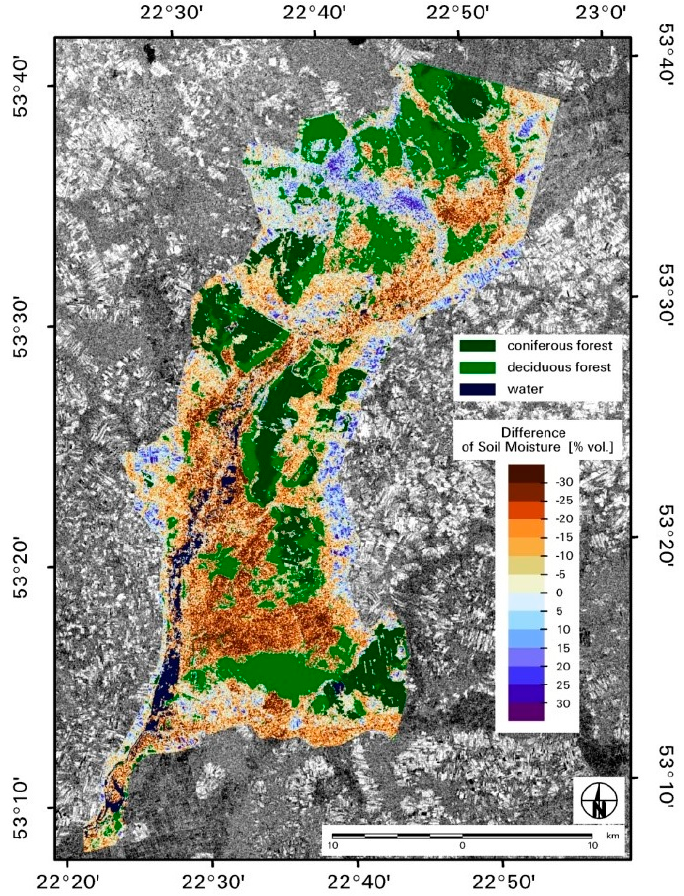
Figure 14. Soil moisture difference map created by applying dates: 10 July 2015 and 11 June 2015.